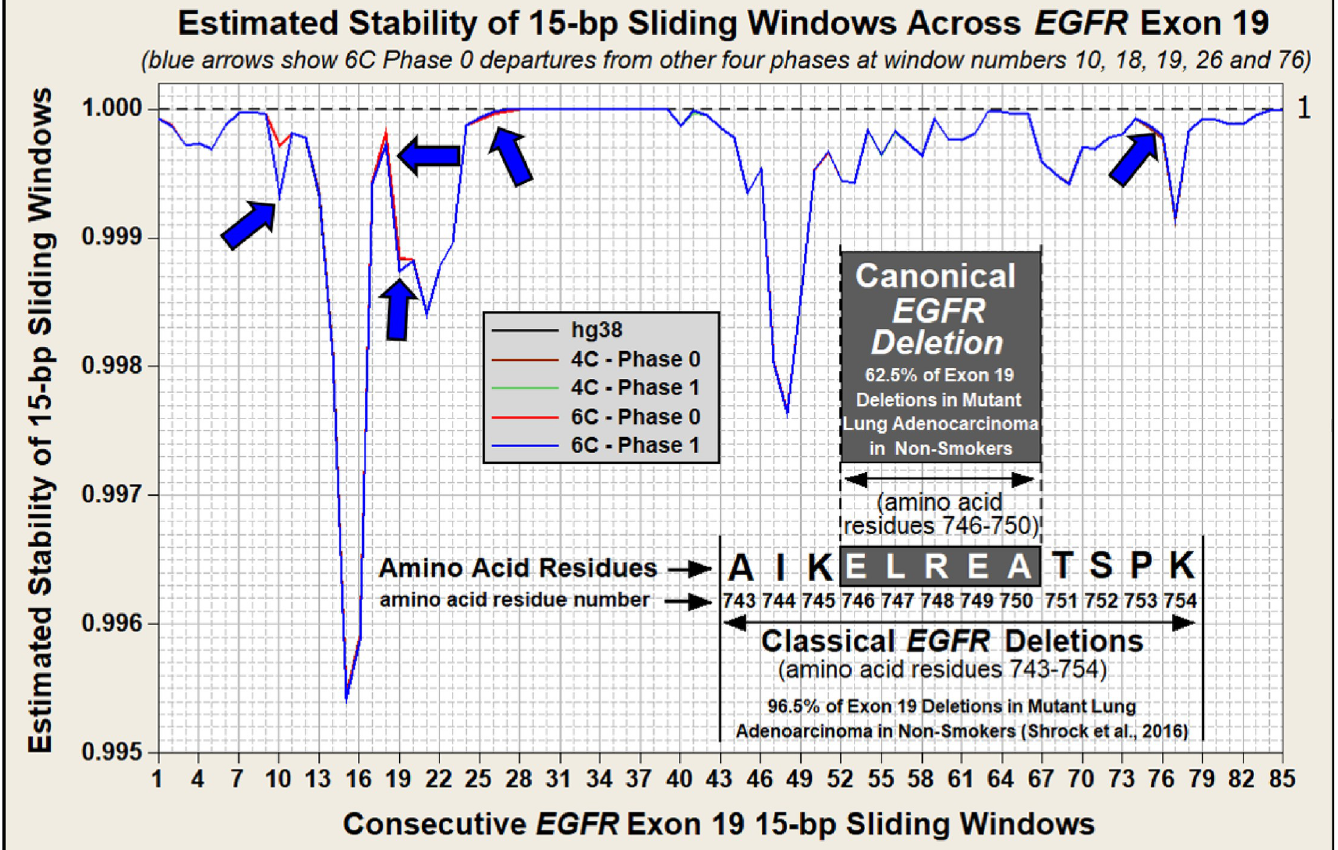
Fig 3. Estimated stabilities of EGFR exon 19 for five genomic phases with overlapping 15 bp windows. The increment for these windows is one base pair. Note that while these five phases present similar estimated stabilities, they are not identical. The blue arrows identify exon 19 regions where the stabilities are most dissimilar. As with Fig 2, the X axis covers only 85 bp. This is because the last 15 bp window extends from base number 85 through base number 99.